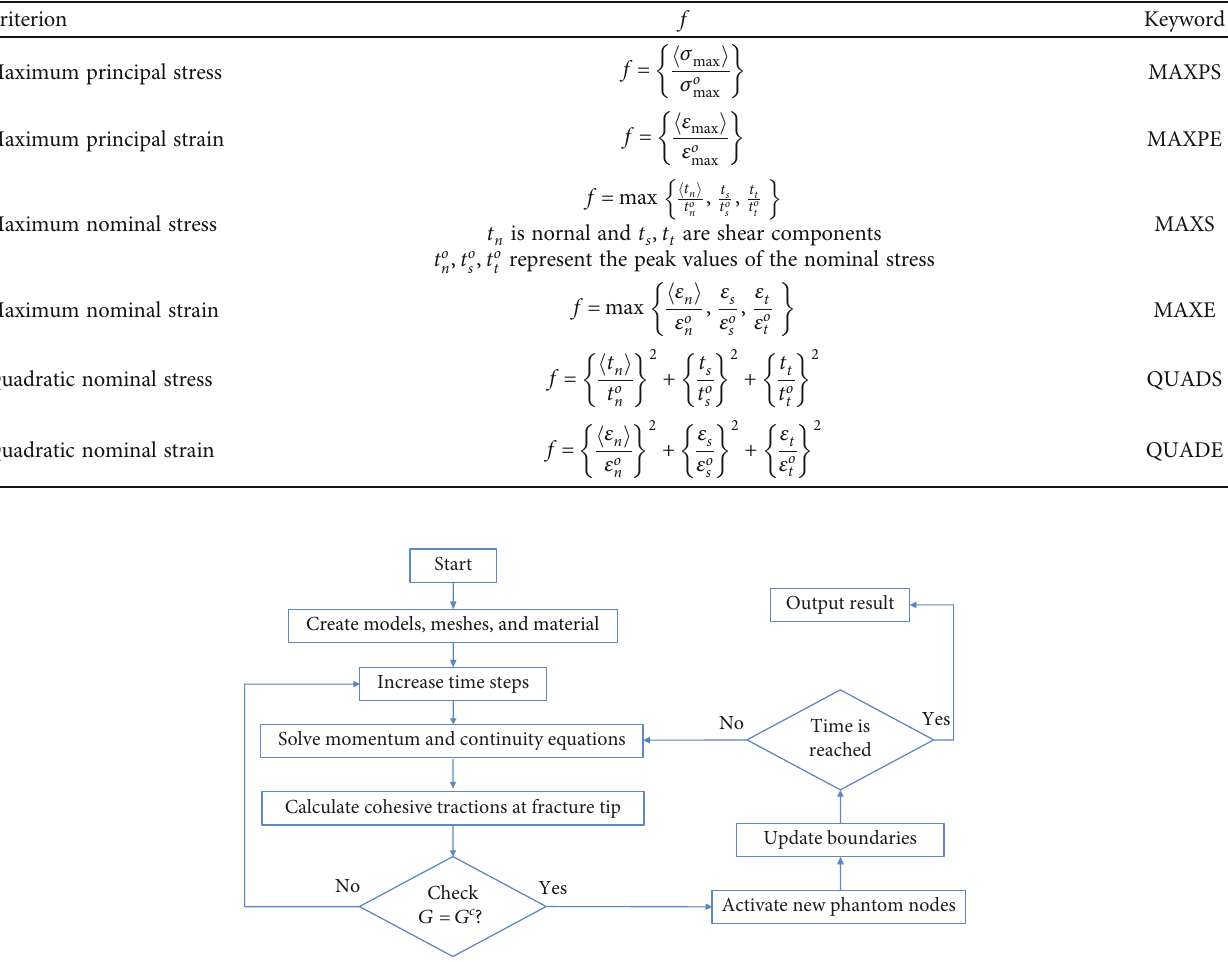
Figure 3: Modeling work fl ow of the fracture ’ s